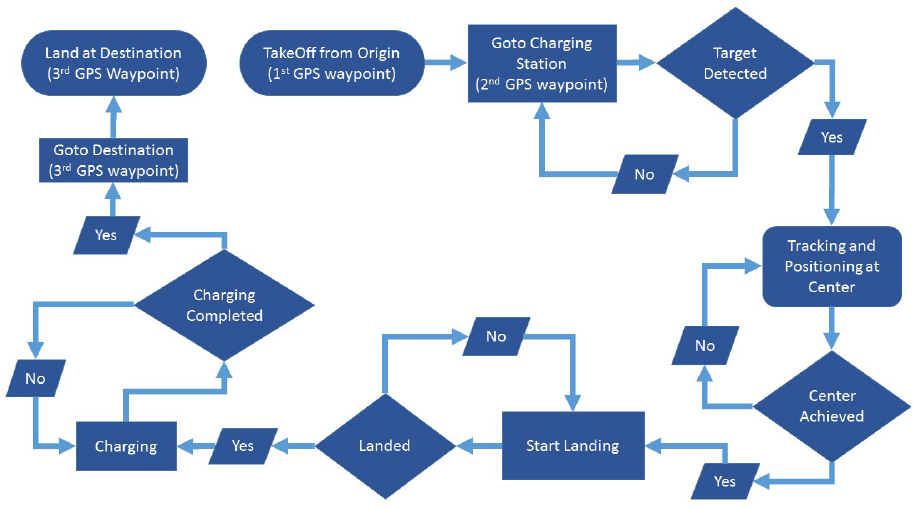
Figure 3. Proposed scheme for the persistent unmanned aerial vehicle